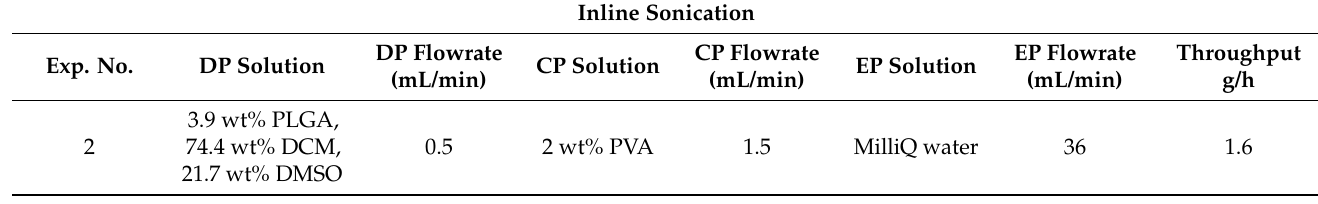
Table 2. Process parameters for the inline sonication method. Inline Sonication